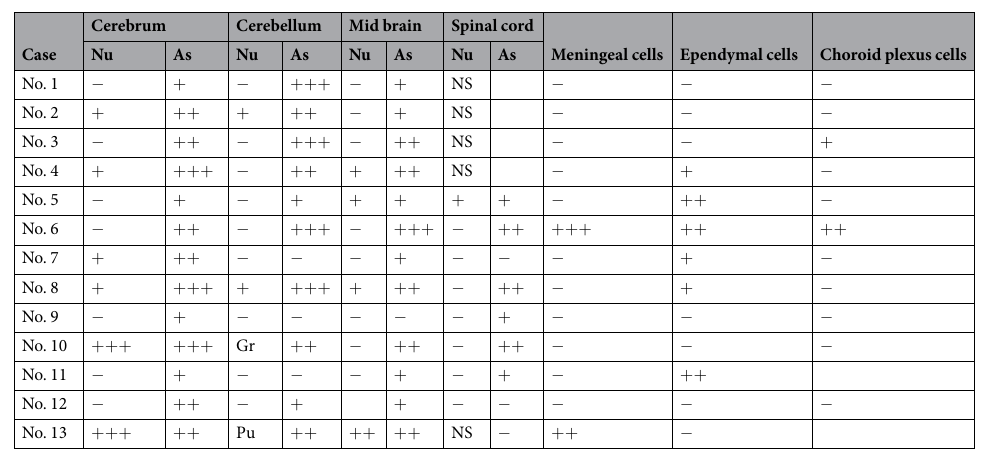
Table 3. Semi-quantitative distribution of CDV antigen in central nervous system a by immunohistochemistry. sample available. a Central nervous system: Nu: Neuron, As: Astrocyte, Gr: Granular cells, Pu: Purkinje’s